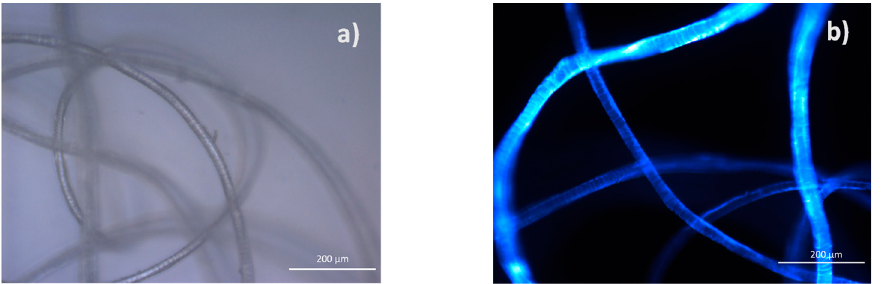
Figure 14. Optical micrographs of the reference wool fibers: original ( a ) and with a fluorescence filter set ( b ).